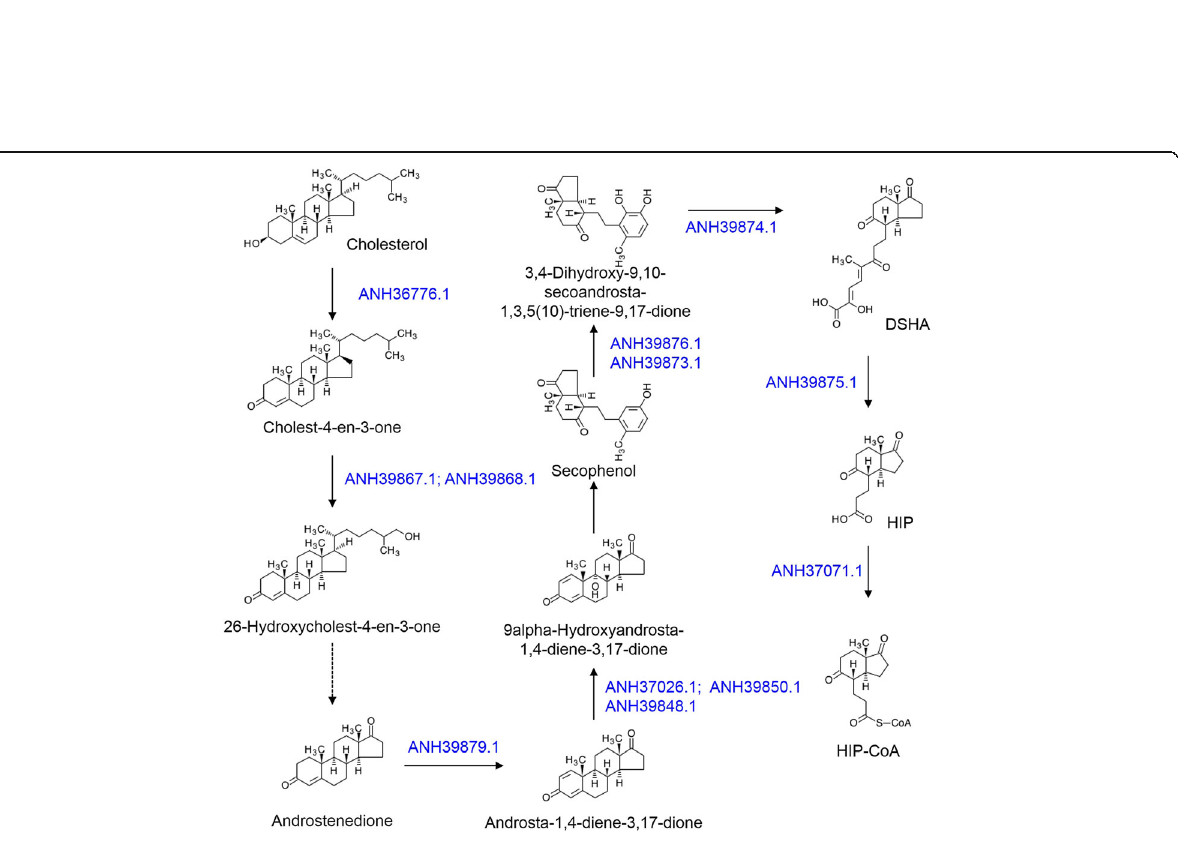
Fig. 5 Cholesterol degradation pathway. Metabolic pathway was referred from the KEGG pathway map 00984. Blue indicates gene accession numbers involved in the cholesterol degradation in N. dokdonensis FR1436. DSHA, 3-hydroxy-5,9,17-trioxo-4,5:9,10-disecoandrosta-1(10),2-dien-4-oate; HIP, 9,17-dioxo-1,2,3,4,10,19-hexanorandrostan-5-oic